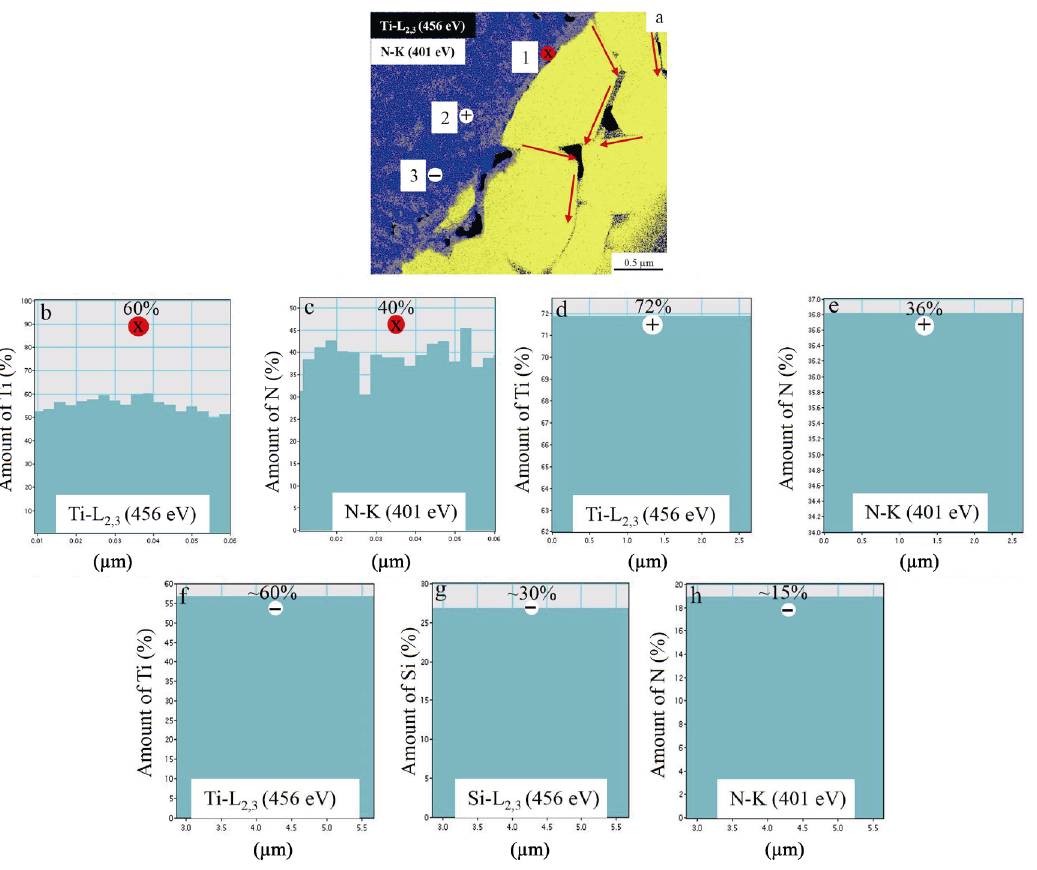
Fig. 4 (a) EFTEM − SI spectrum image (50–650 eV), (b, c) atomic quantity of Ti and N from point 1 (marked with red), (d, e) atomic quantity of Ti and N from point 2 (marked with green), and (f − h) atomic quantity of Ti, Si, and N from point 3 (marked with yellow) in (a).